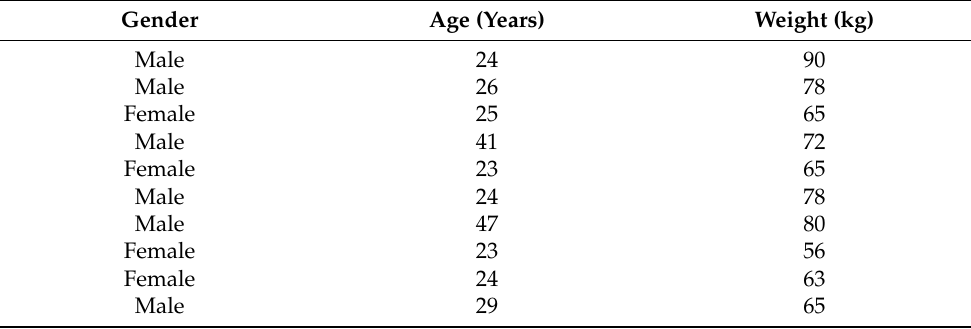
Table 2. Information about the subjects in the ambulatory system